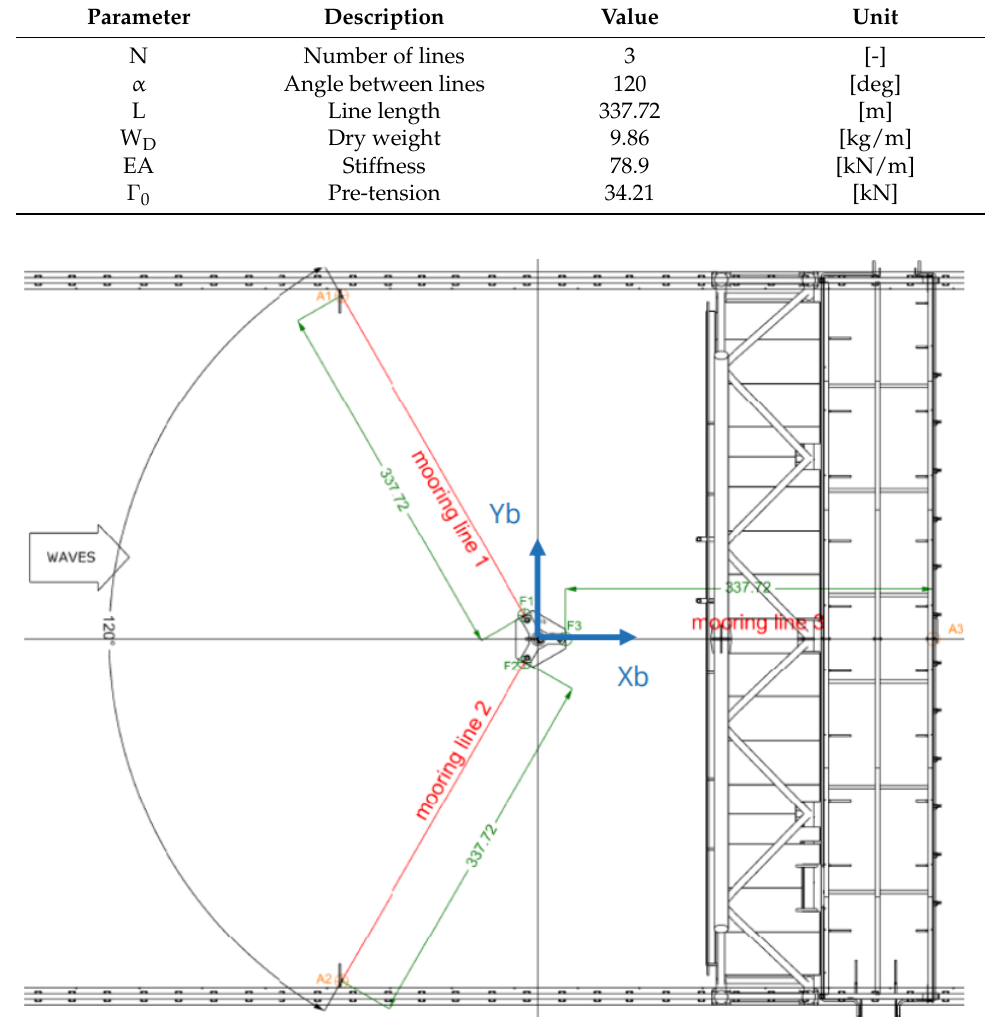
Figure 2. Scheme of the experimental facilities with the mooring lines configuration. Table 2. Mooring parameters. Table 3. Fairleads and anchors